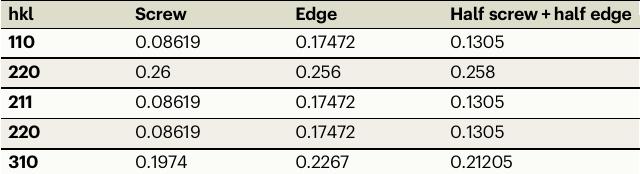
-- C for different crystallographic